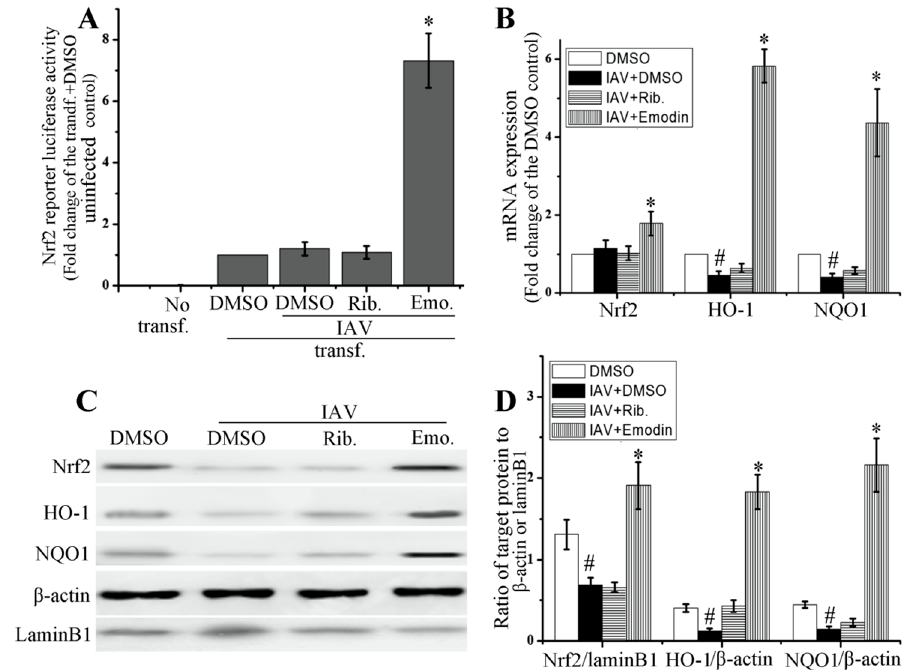
Figure 4. Effect of emodin on Nrf2 pathway after IAV infection. ( A ) Emodin promoted the transcription of Nrf2 luciferase reporter. A549 cells (1 × 10 6 ) were transfected with ARE-luc and pRL-TK-Rluc. After 8 h, cells were infected with IAV (ST169, H1N1, MOI = 2) and treated with ribavirin (Rib. 25 μ g mL − 1 ) and emodin (Emo. 25 μ g mL − 1 ). After 24 h at 37 °C 5% CO 2 , the firefly luciferase activity was detected, normalized to that of renilla luciferase and expressed relative to the tranfected (tranf.), DMSO-treated but IAV-uninfected control; ( B , C and D ) Effect of emodin on the mRNA expressions of Nrf2, HO-1 and NQO1, nuclear translocation of Nrf2 and the protein production of HO-1 and NQO1. DMSO (0.5%, v / v ), ribavirin (25 μ g mL − 1 ) or emodin (25 μ g mL − 1 ) were beforehand mixed with IAV (MOI = 0.001) and added to A549 cells for 24 h. The mRNA levels were determined by RT-qPCR. The protein levels were determined by western blotting. Data were mean ± SD of five independent experiments, n = 5. * p < 0.05 vs. the tranf. + IAV + DMSO control ( A ) or vs. the IAV + DMSO control ( B , D ), # p < 0.05 vs. the DMSO control ( B , D ).